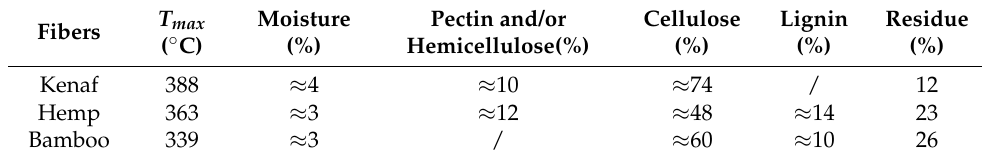
Table 2. TGA data of the fibers.